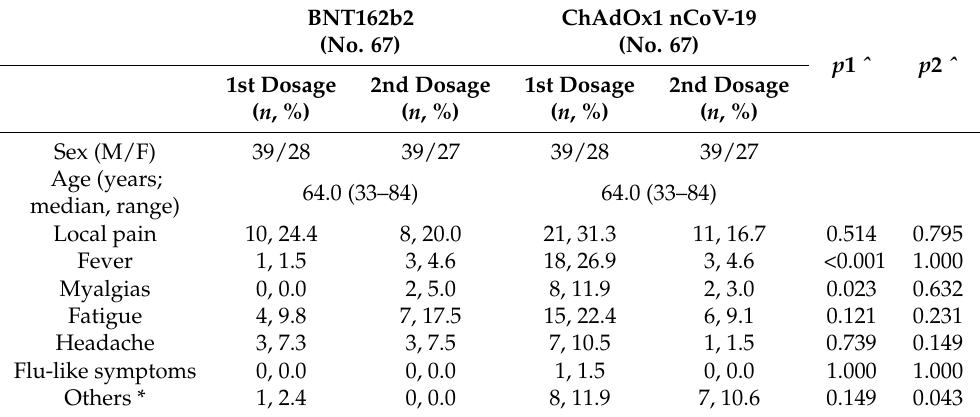
Table 3. Comparison of adverse reactions after vaccination with BNT162b2 and ChAdOx1 nCoV-19